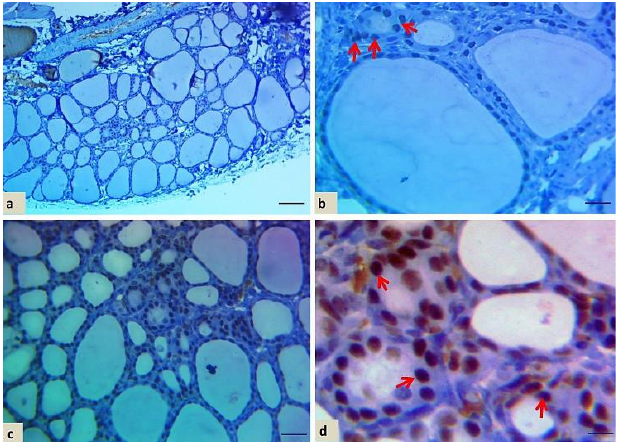
Figure 11. Immunohistochemical brownish nuclear staining of TTF-1 expression in thyroid gland of diabetic rats treated with 500 mg/kg BW and 1000 mg/kg BW of QIg extracts for 15 days ( a and b ): Diffuse, moderate expression (sum score 6) in 500 mg/kg/BW extracted QIg group, (100× and 400×), ( c and d ): Focal-weak expression (2) in group in 1000 mg/kg/BW extracted QIg group, (100× and